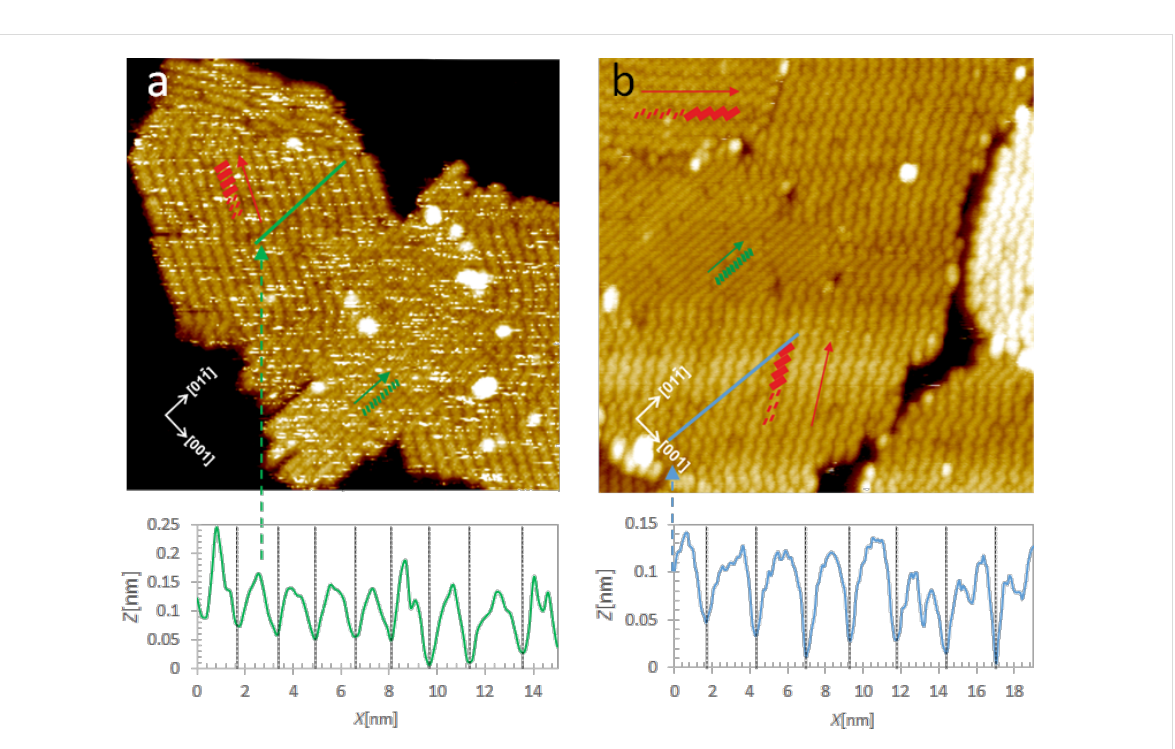
Figure 6: 50 × 50 nm empty state STM images of ZnPc (a) and CuPc (b) structures formed on top of the ZnTPP wetting layer covering the TiO 2 (011)- (2×1) surface by thermal deposition of 0.1–0.2 ML of molecules and subsequent annealing at 150 °C. Arrows and rectangles indicate the ordering directions and the basic molecular building blocks, i.e., upright standing molecules. The profiles taken along those predominant directions of the mo- lecular chains are shown below the STM images. Scanning parameters: I = 5 pA; U = 2V.